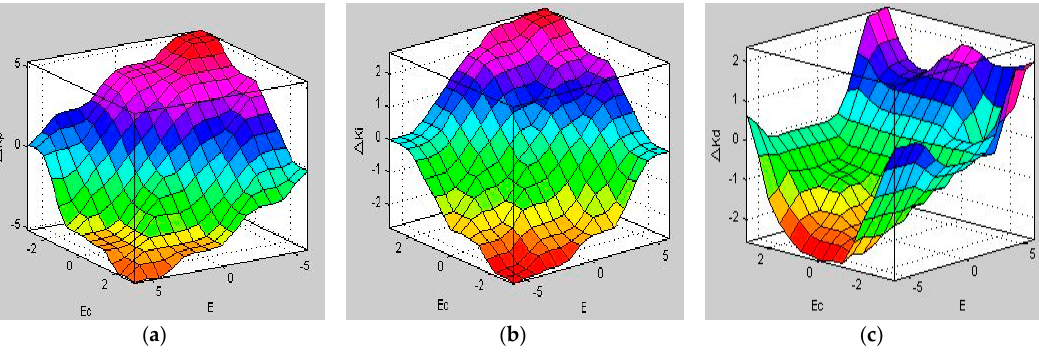
Figure 8. Fuzzy rules: ( a ) K p rules ( b ) K i rules ( c ) K d rules.